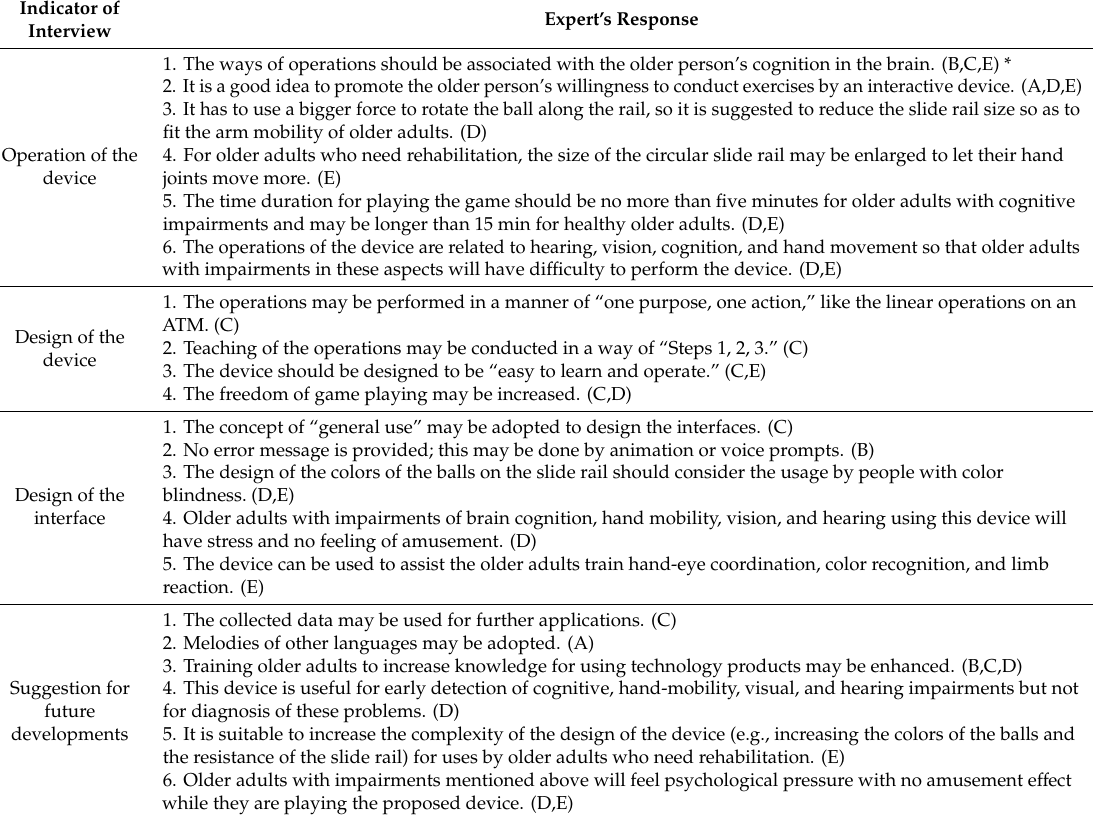
Table 7. List of opinions collected from interviews with